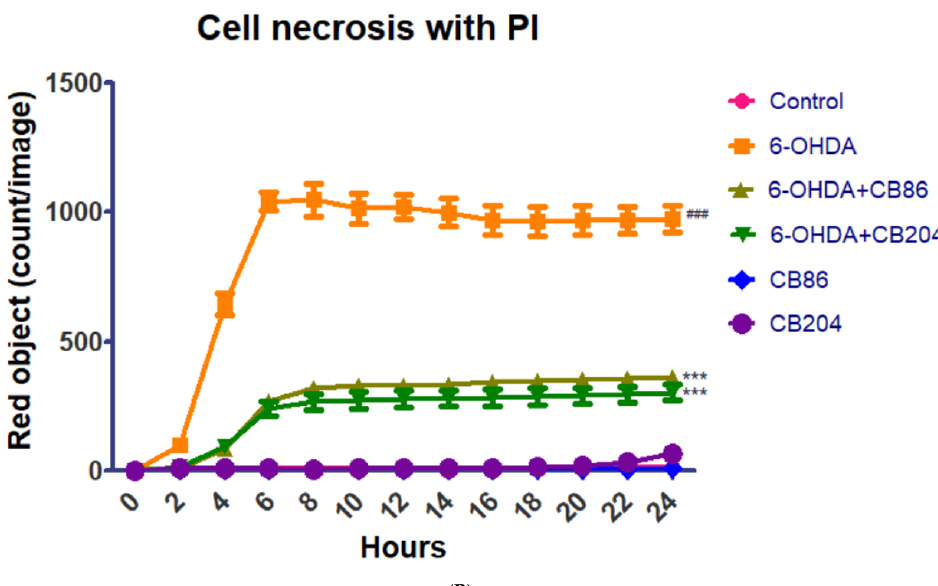
Figure 2. Cell necrosis assay with PI: PC12 cell necrosis was induced by exposure to 80 µM 6-OHDA and simultaneously treated or untreated with CB86 or CB204 (25 µM each) for 24 h. ( A ) shows microscopic images phase confluence vs PI with scale bar 0-200 µm and ( B ) red object count from 0-24 h. Results are expressed by mean ± SEM ( n = 4 replicates in each group). ANOVA followed by Bonferroni’s post-hoc test was performed, ### compared to control; *** compared to 6-OHDA group alone, p < 0.001 for both.